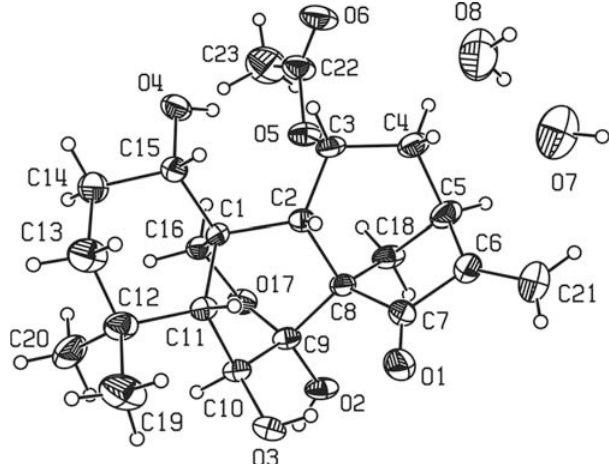
Table 1. Data collection and handling.